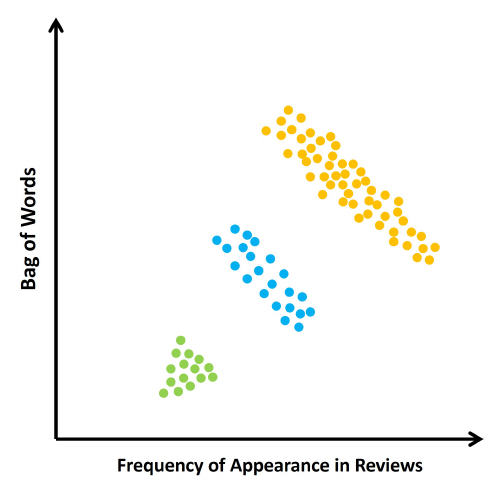
Figure 5. The clusters are in pyramidal form.